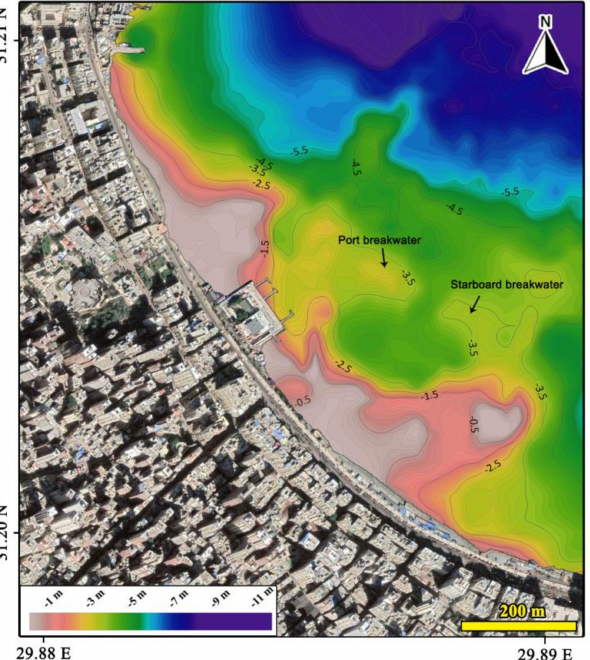
Figure 4. Bathymetric contour map of the study area showing the submerged ancient